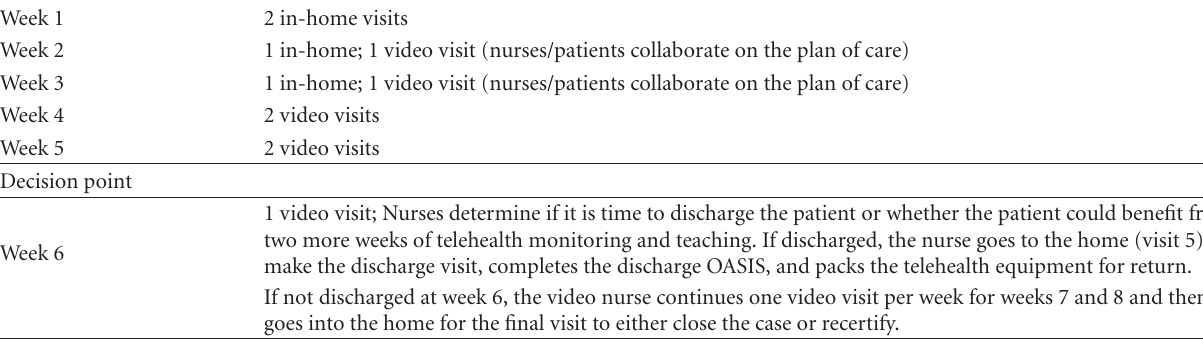
Table 1: Visit protocol for telehealth